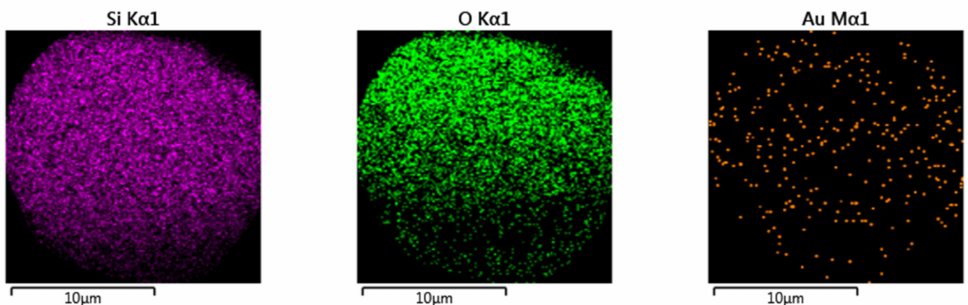
Figure 16. HRTEM images of Au nanoparticles inside SiO 2 from (PS-co-4-PVP) • (AuCl 3 ) n • (SiO 2 ) n precursor. Adapted from reference [94].